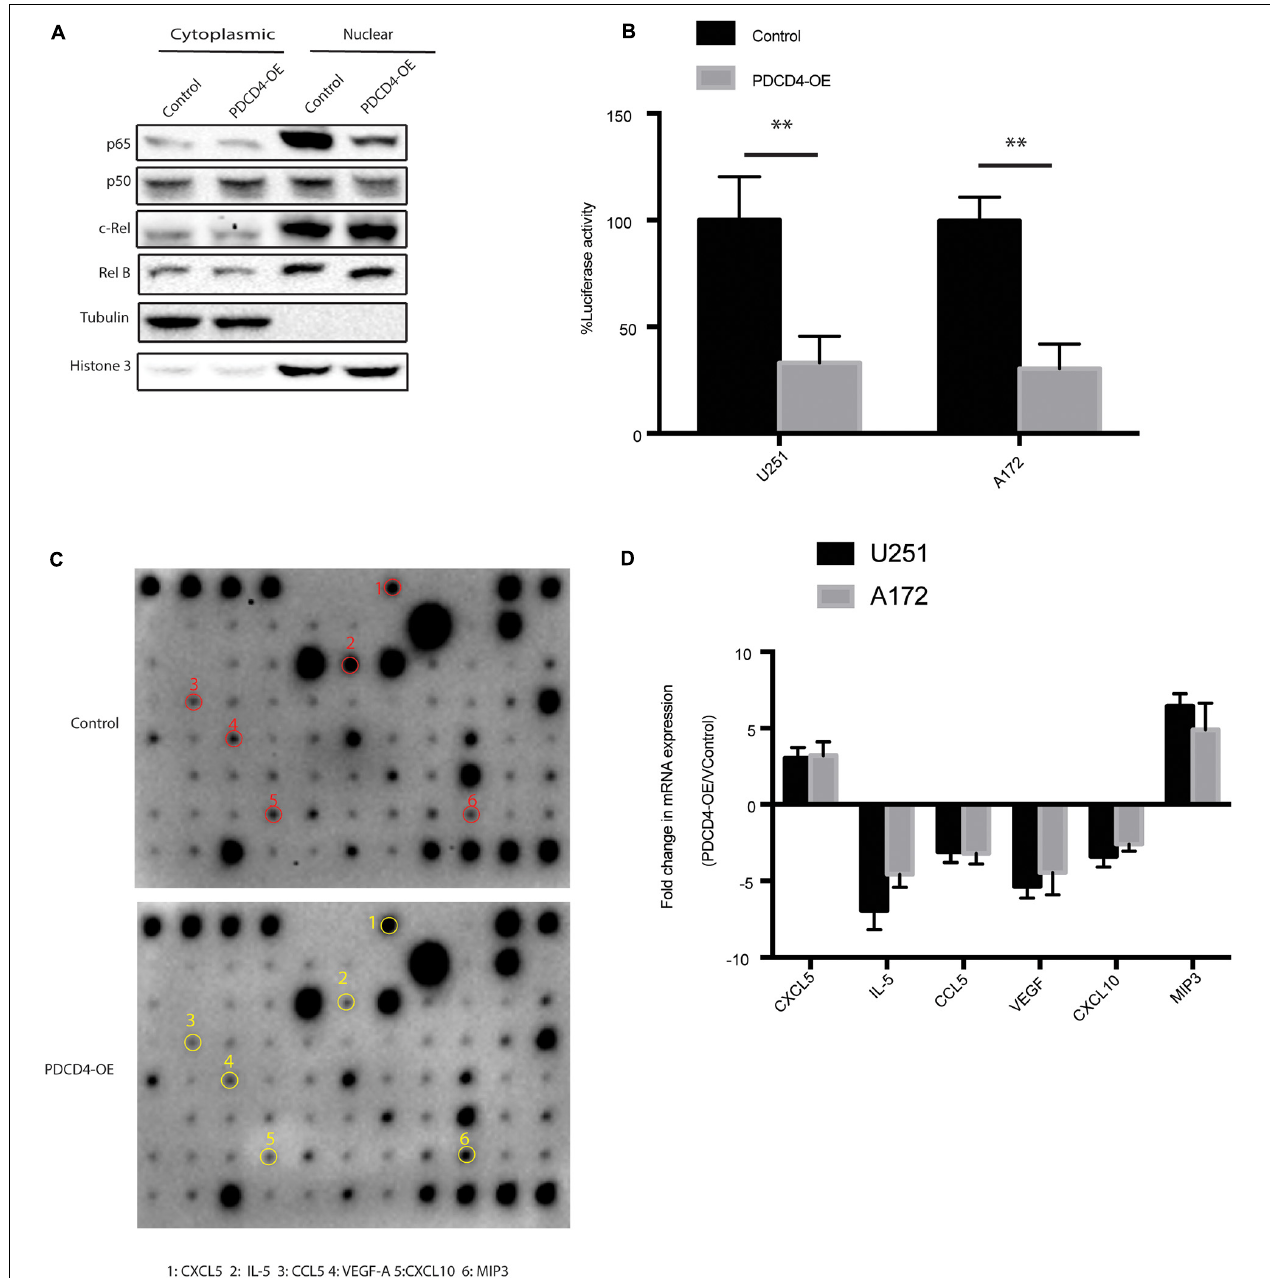
FIGURE 3 | PDCD4 regulates production of IL-5, CCL-5, VEGF, and CXCL10. (A) Western blot analysis of nuclear and cytosolic fractions of indicated cells. Histone 3 and tubulin are used as nuclear protein marker and loading control, respectively. (B) Luciferase reporter assay showing NF- κ B transcriptional activity in cells over-expressing PDCD4 . (C) Cytokine assay indicating levels of cytokines and chemokines in conditional media collected from cells over-expressing PDCD4 . (D) Real-time PCR analysis depicting mRNA fold changes of the indicated genes in the cytokine assay. ** P <